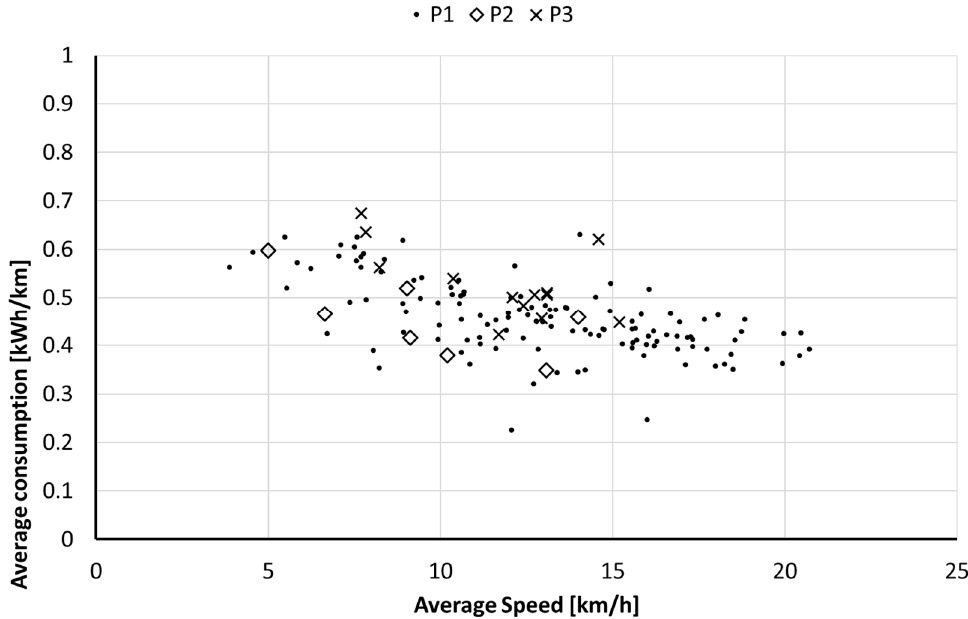
Figure 12. Trend of energy consumption related to average speed.